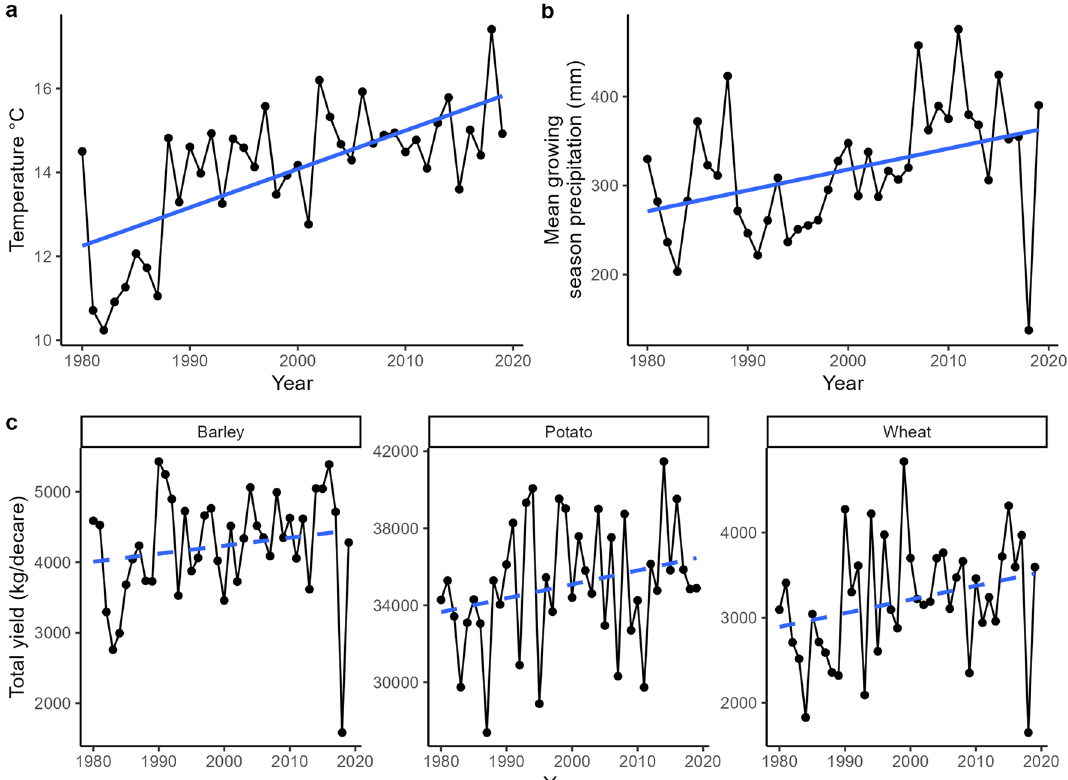
Figure 1. Country-level time series of ( a ) mean growing season temperature, ( b ) mean growing season precipitation and ( c ) total yields of the three study crops. Solid blue lines are significant (p < 0.05) linear regression lines. Dotted lines are non-significant linear trend